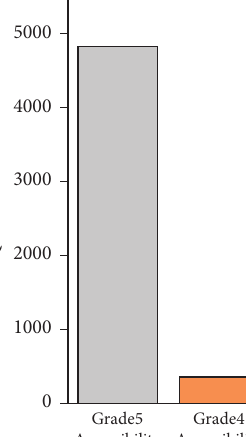
Figure 7: Accessibility performance during evening peak hours.